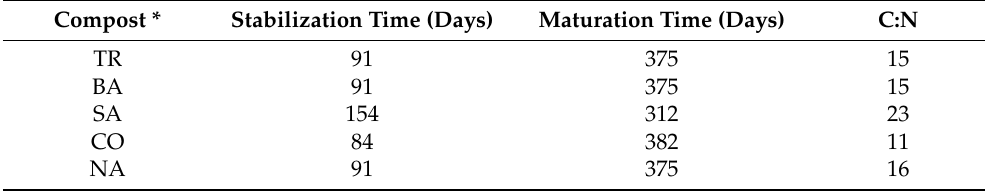
Table 1. Compost stabilization time, maturation time, and final C:N ratio. Composts were made from poultry industry wastes and tree trimmings (TR), sugarcane bagasse (BA), sawdust (SA), cotton residues (CO), and Napier grass